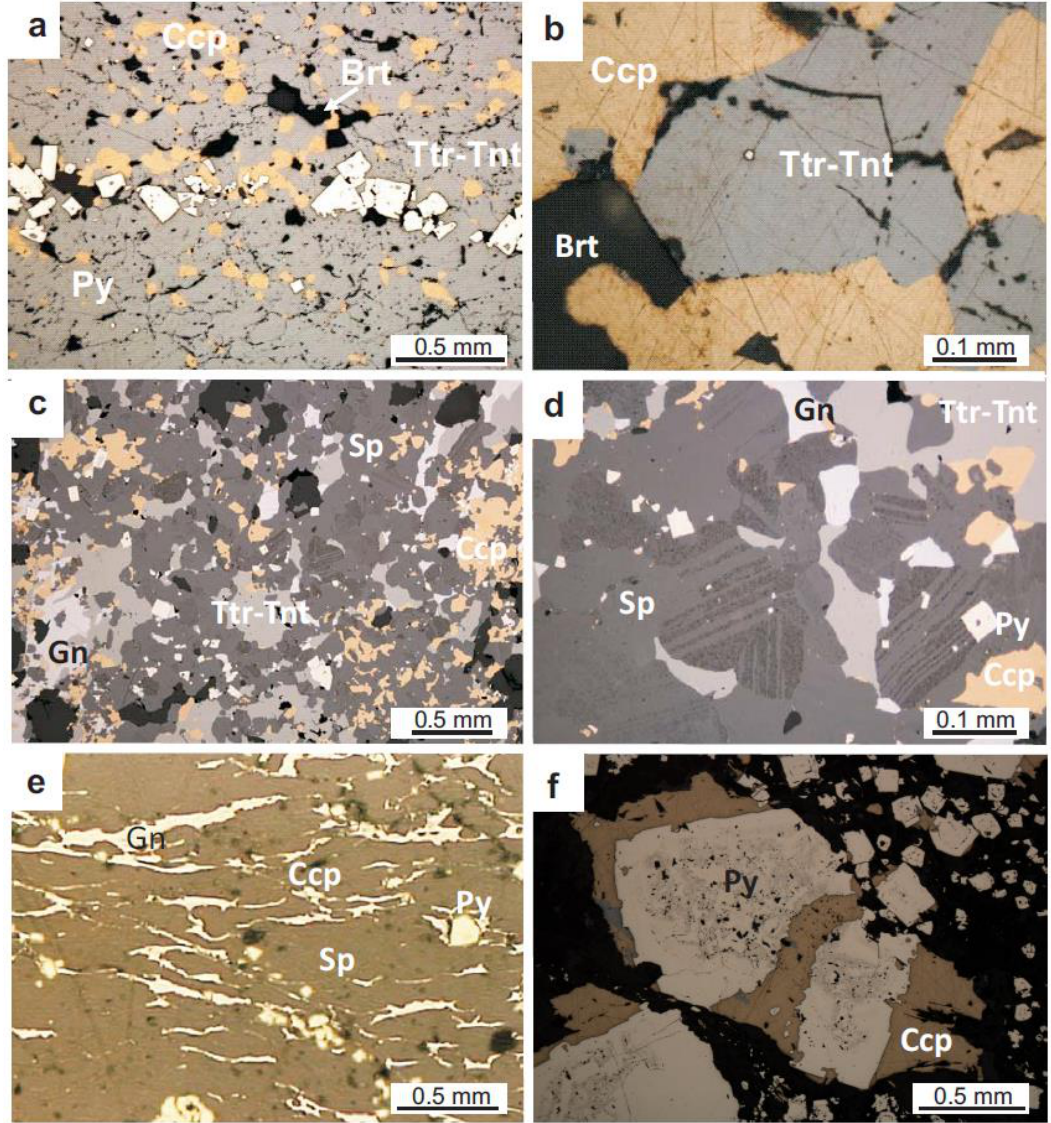
Figure 9. Optical microscope images of polymetallic mineralizations with As–Sb and deformed facies from several massive sulfide deposits of the IPB. ( a , b ) Annealing textures. Equigranular chalcopyrite (Ccp) and tetrahedrite (Trt) aggregates showing 120° triple junctions in grain boundaries; ( c , d ) sphalerite (Sp) showing lamellar twins and triple junctions; ( e ) sphalerite segregation favored by shearing deformation bands; ( f ) subidiomorphic pyrite (Py) porphyroclast showing chalcopyrite pressure shadows. Magdalena deposit ( a – d , f ) and Frailes deposit ( e ).